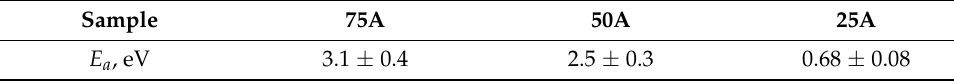
Table 4. Conduction activation energy for composites of different